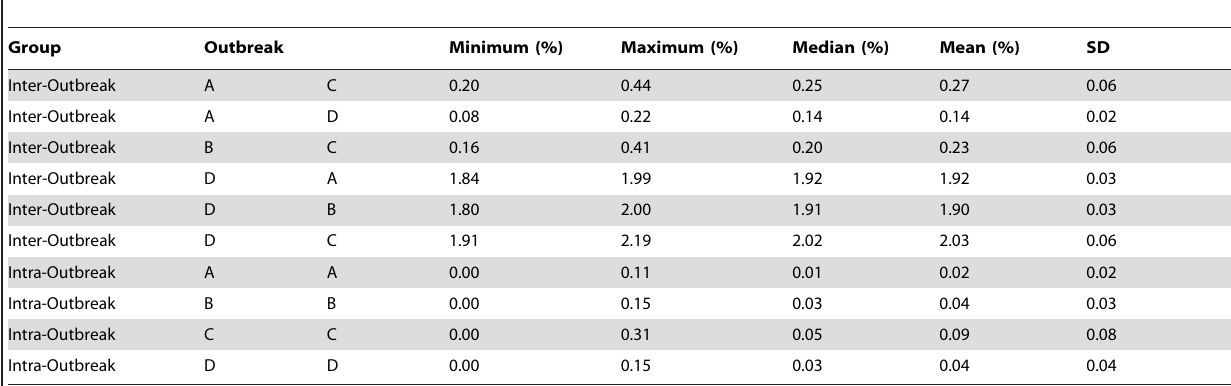
shown in Table 1. PCR amplification was carried out on LightCycler 480 (Roche). Melting curve analysis was performed to identify PCR-positive samples. Both DNA strands were